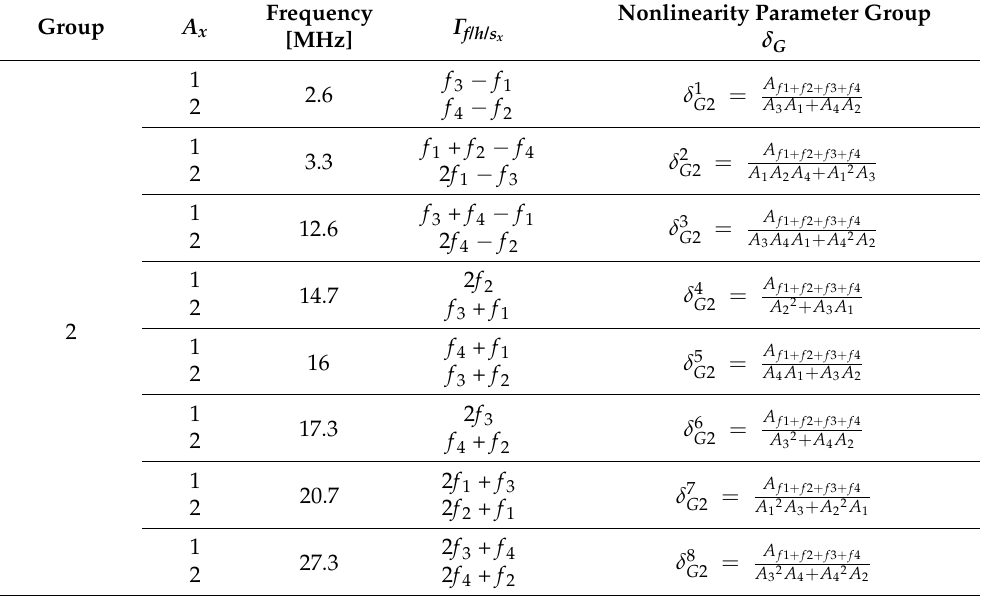
Table 3. Nonlinearity parameter group 2, δ G 2